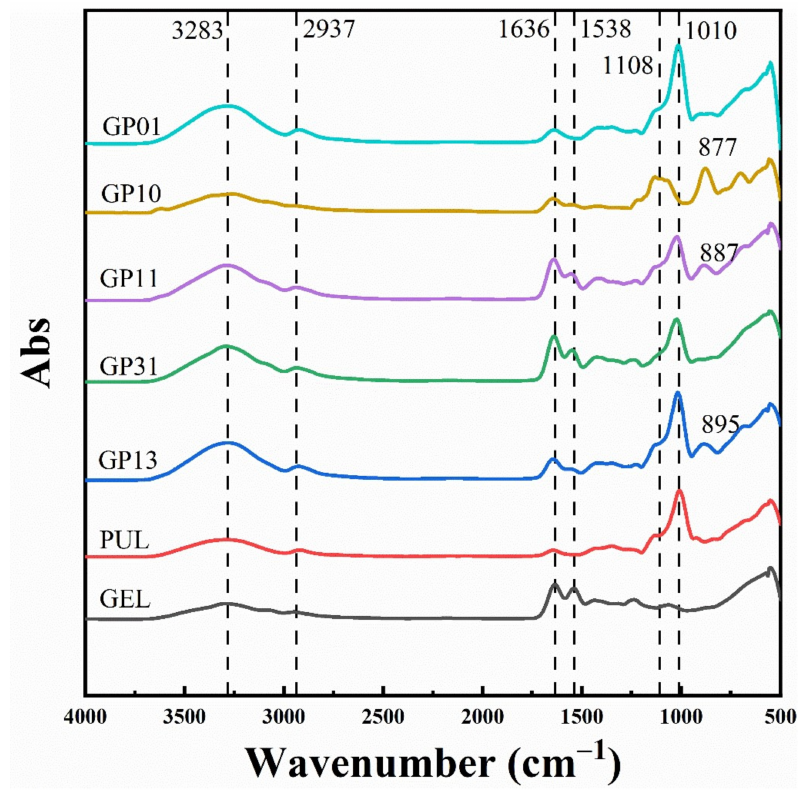
Figure 1. FTIR spectrum of different